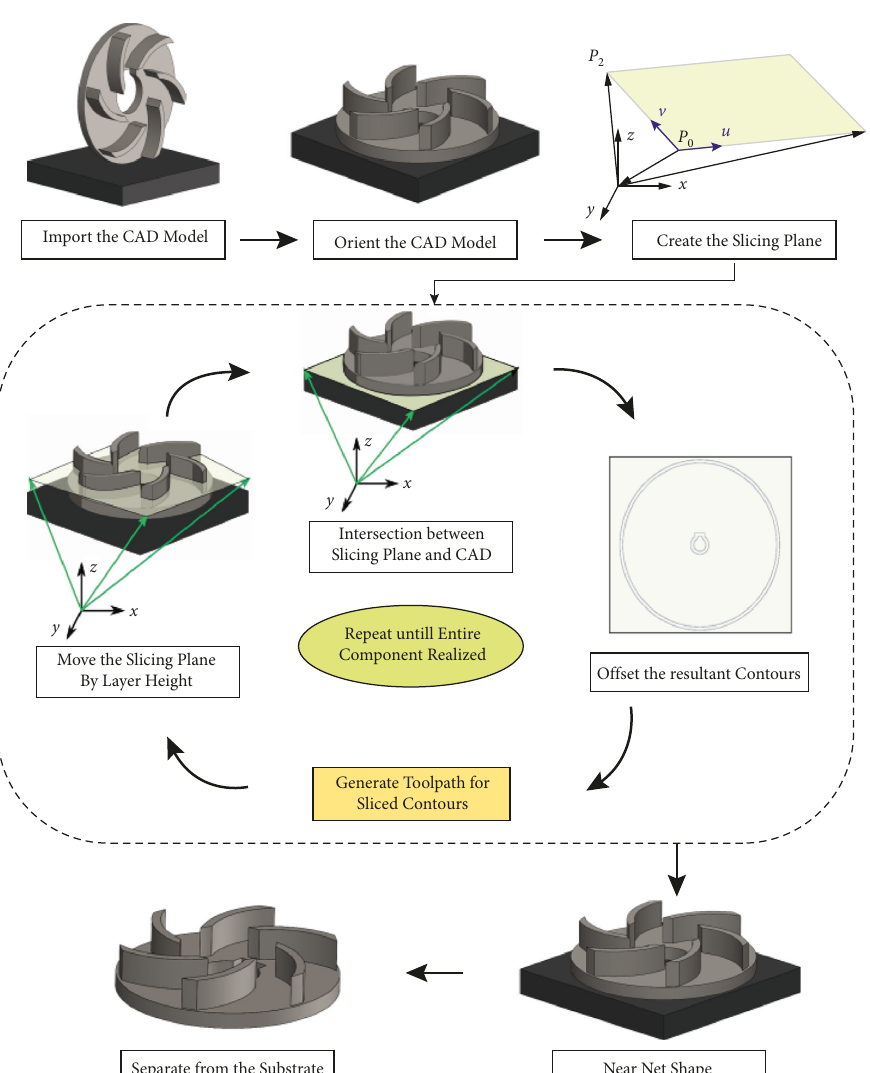
Figure 15: Process flow for reusable substrate